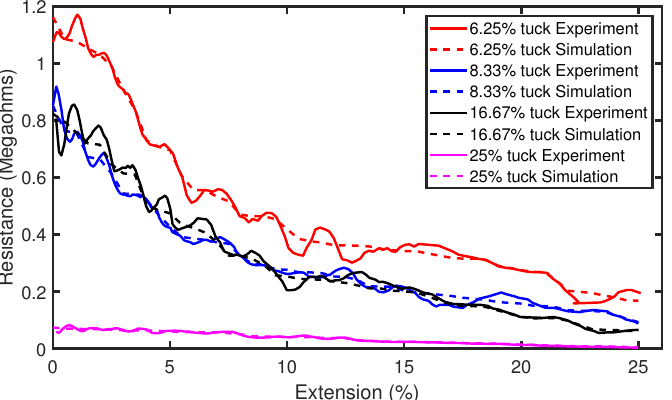
Figure 10. Comparison of simulation and experimental results for sensors with tuck